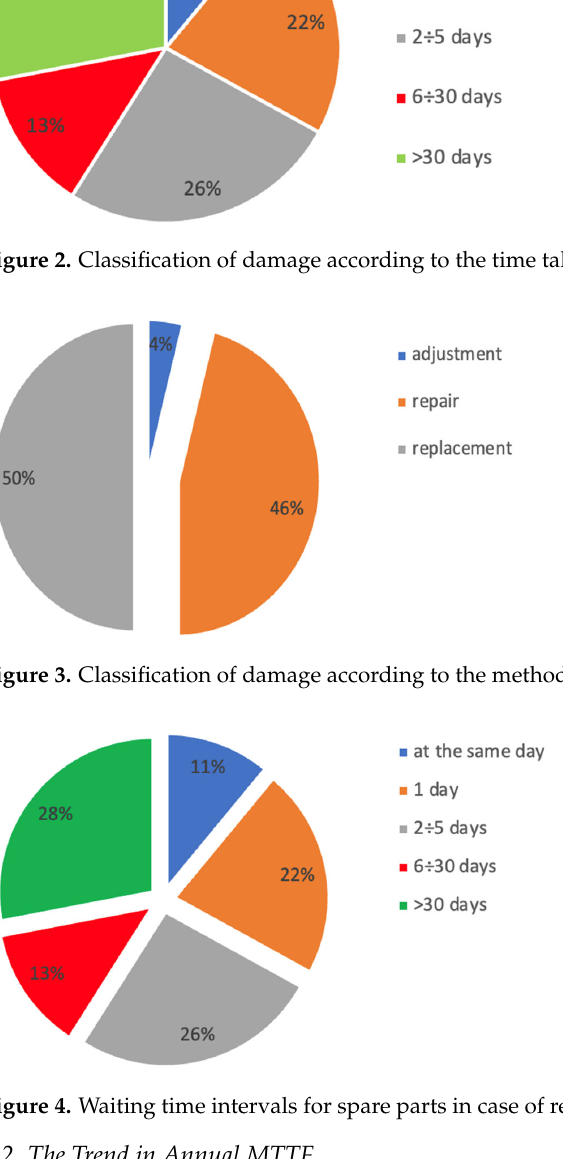
Figure 4. Waiting time intervals for spare parts in case of replacement.